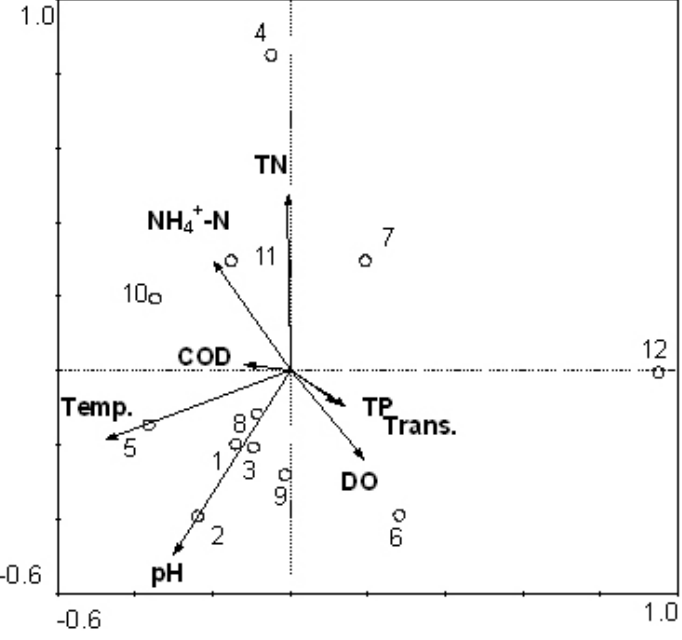
Figure 5. CCA ordination diagram of the cyanobacteria community dynamics data (from PCR-DGGE approach) in relation to the environmental variables. 1–6: samples from July to December in Tiegang Reservoir: 7–12: samples from July to December in Shiyan